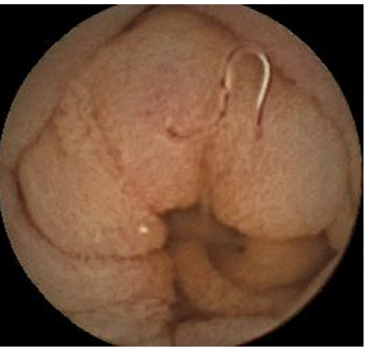
Figure 2. Hookworms identified by CE. Hookworms throughout the small bowel were identified by CE in a 42-year-old woman with lower abdominal pain for three years.